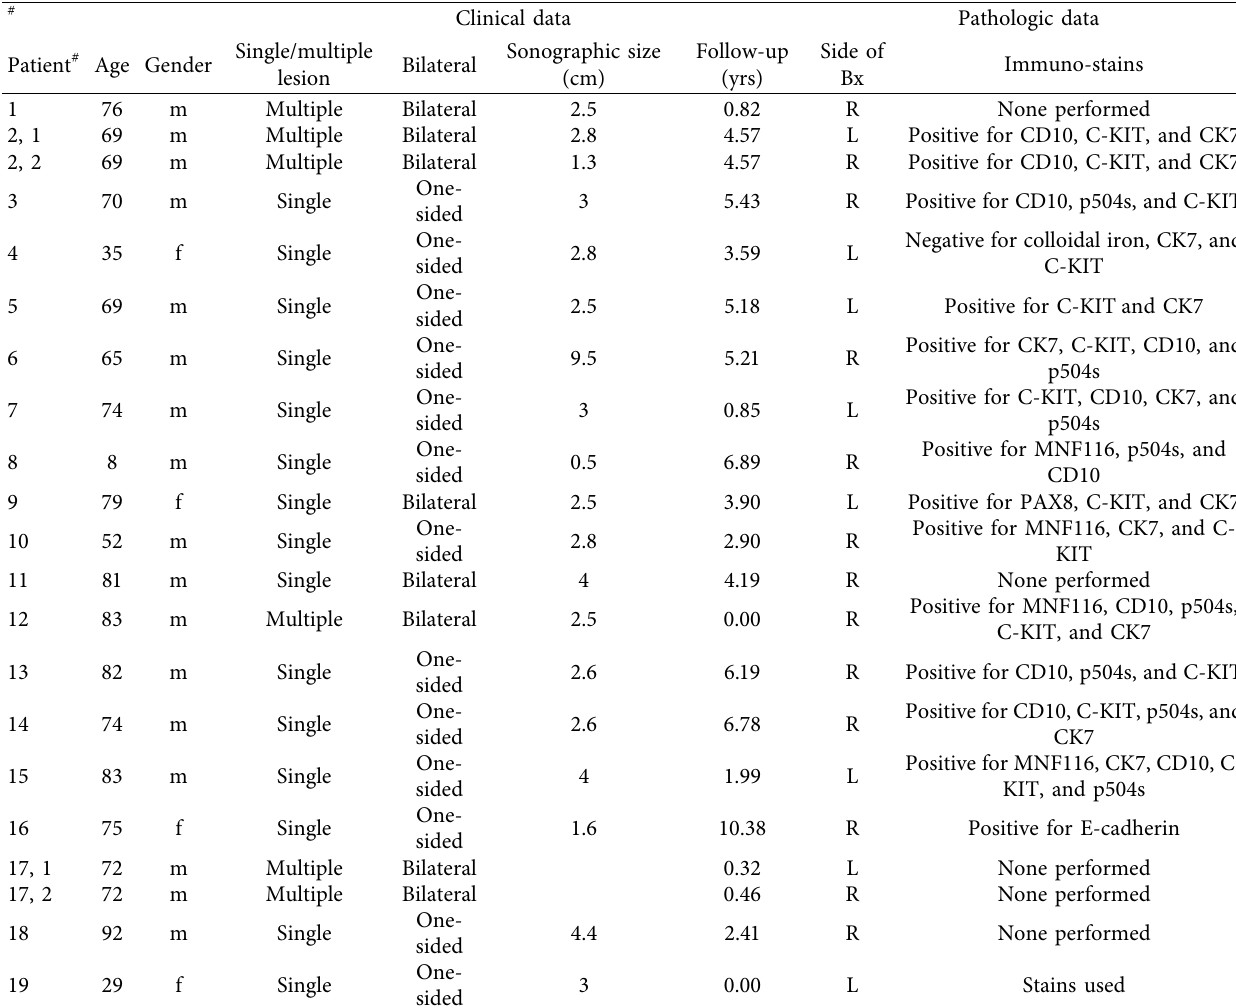
Figure 2: Typical immunostaining of oncocytomas, as seen in one of the cases detailed (left to right: H&E staining, positive C-KITstaining, and negative CK7 staining). Table 1: Clinical and pathologic